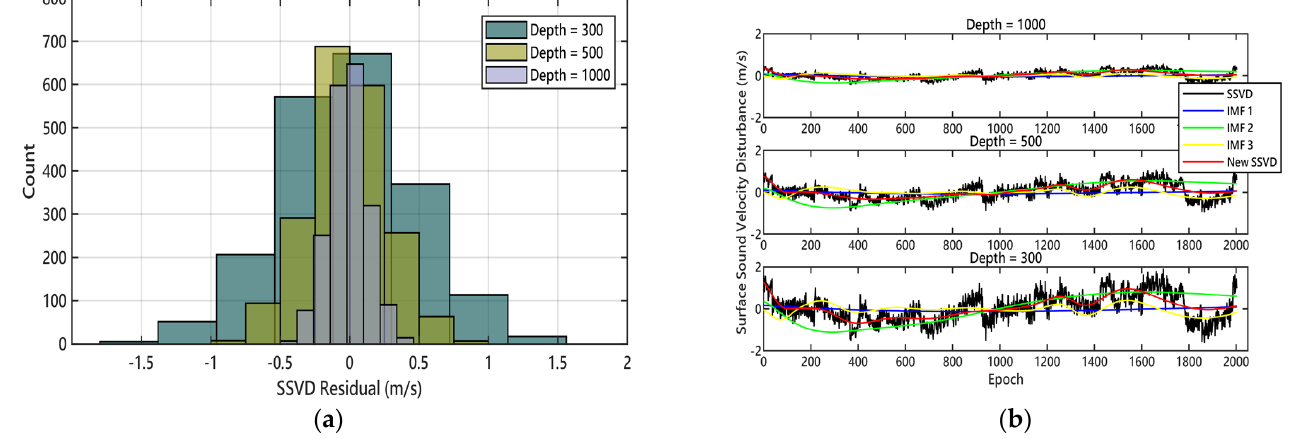
Figure 12. The histogram of surface sound velocity disturbance with different surface reference depths ( a ). The intrinsic mode functions of surface sound velocity disturbance with different reference depth using the IMF method ( b ).